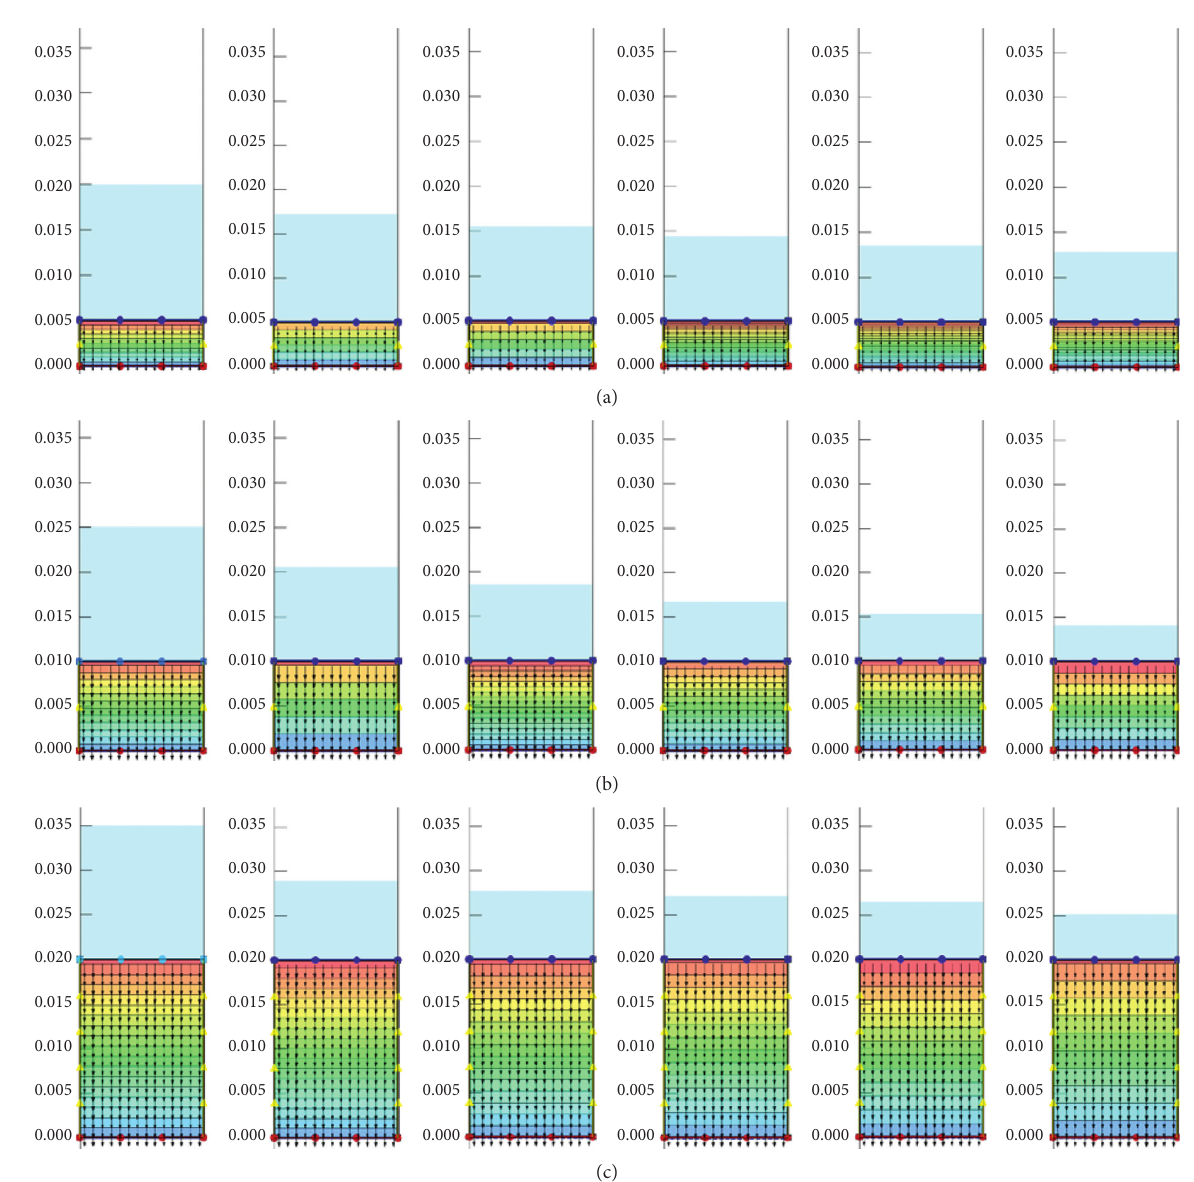
Figure 12: Numericalsimulationtotal waterhead stressclouddiagramwithdifferent thicknessand 0.5mmat differenttimes:(a)0.5mm/5cmsoil column pressure head at different times. (b) 0.5mm/10cm soil column pressure head at different times. (c).5mm/20cm soil column pressure head at different